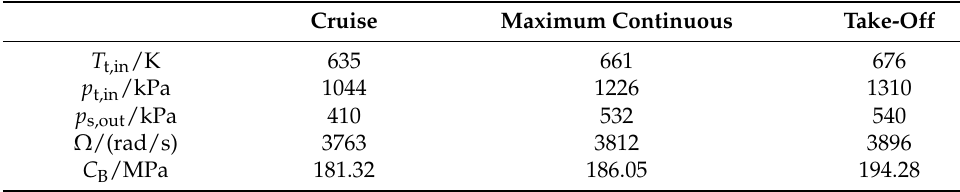
Table 2. Boundary conditions of three typical operating